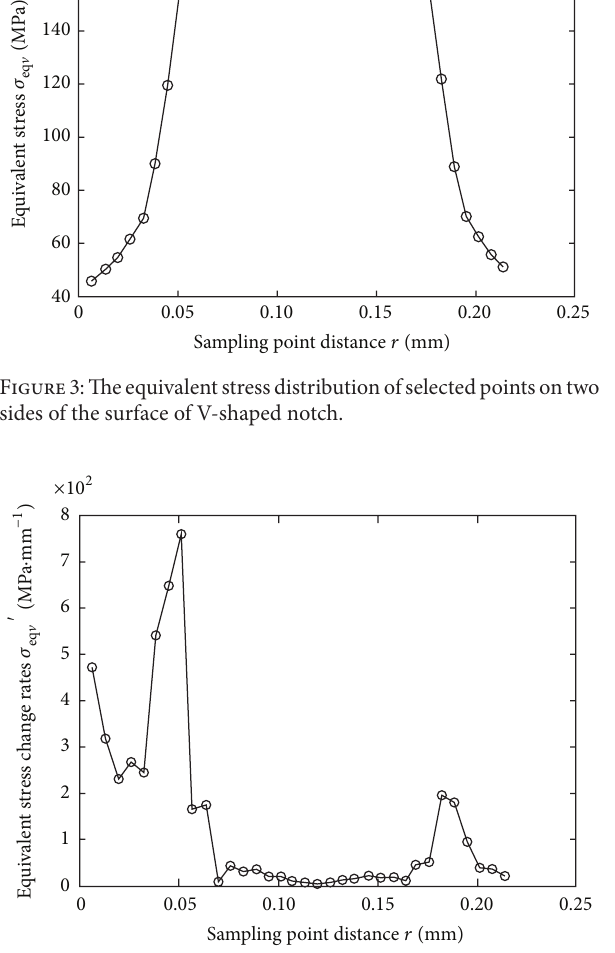
stress point. In order to further investigate the factual fracture of V-shaped location, the equivalent stress change rate 𝜎 󸀠 eqv notch is presented in this paper and is calculated by 󵄨󵄨󵄨󵄨󵄨 󵄨󵄨󵄨󵄨󵄨𝜎 󵄨󵄨󵄨󵄨󵄨Δ𝜎 󵄨󵄨󵄨󵄨󵄨 𝑖+1 − 𝜎 𝑖 𝑑𝜎 eqv eqv eqv eqv 𝜎 𝑖 = = = 󵄨󵄨󵄨󵄨𝑟 󵄨󵄨󵄨󵄨 , 𝑖 = 1, . . . , 𝑛, (1) |Δ𝑟| 𝑑𝑟 𝑖+1 − 𝑟 𝑖 eqv where 𝜎 𝑖 is the equivalent stress at point 𝑖 on the V-shaped eqv notch surface and 𝑟 𝑖 is the length between point 𝑖 and base point (a point very close to point 𝑖